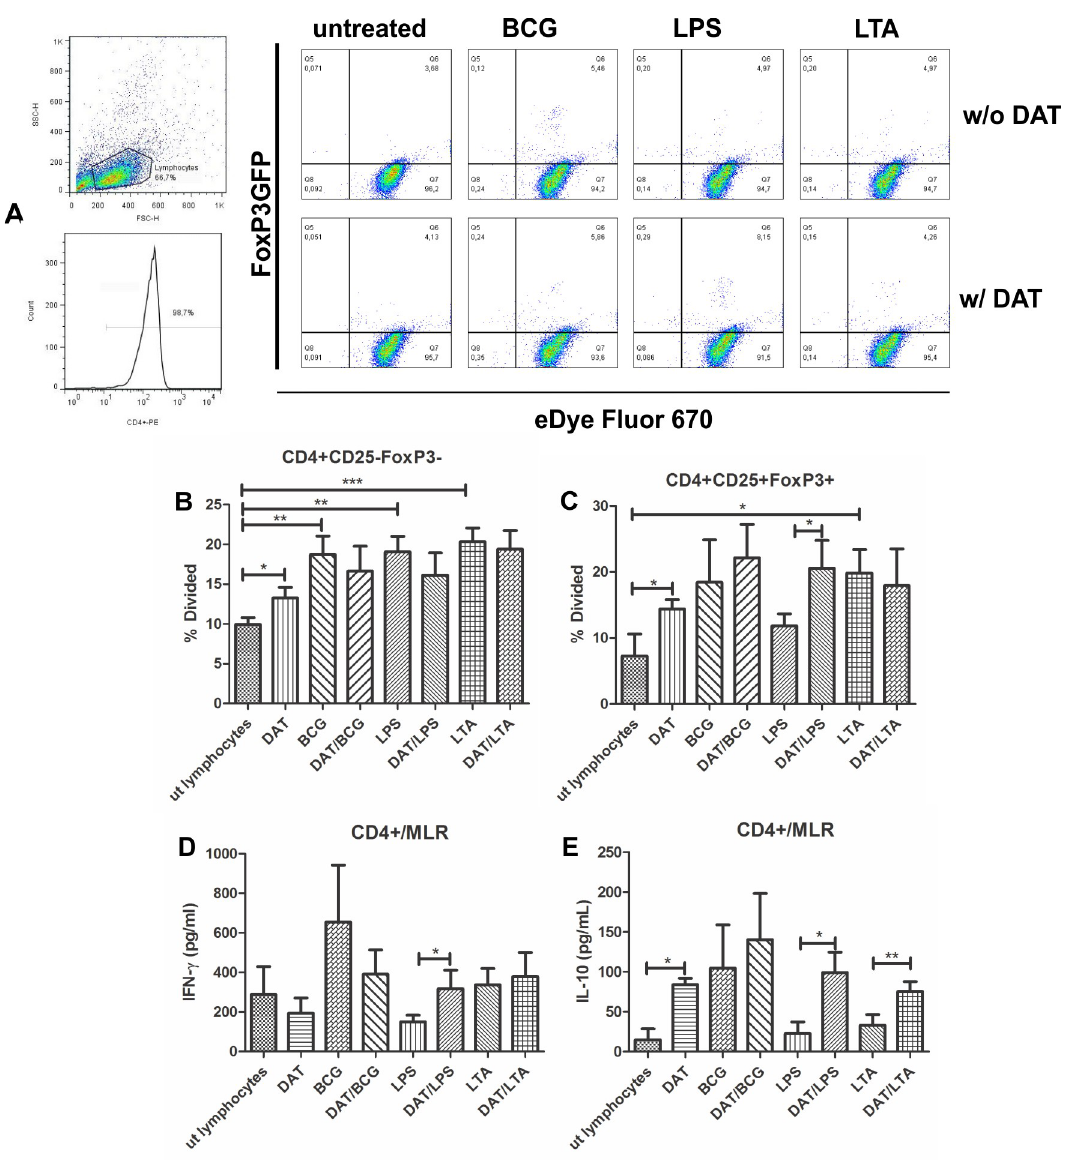
Fig 8. Di- O -acyl trehalose promotes the expansion of regulatory T lymphocytes. We studied the capacity of DCs activated with M . bovis /BCG antigens and TLR agonists with or without preincubation with DAT. DCs were cocultured with lymphocytes CD4 + CD25 - FoxP3 - and CD4 + CD25 + FoxP3 + lymphocytes obtained by cell sorting from Foxp3GFP + transgenic mice. The proliferation was measured by a dilution method with eDye Fluor 670 (A). Proliferation of FoxP3 - lymphocytes was observed in cocultures with DCs activated with DAT, BCG antigens, and LPS (p < 0.05; unpaired t Student’s test) (B). Proliferation of regulatory FoxP3 + lymphocytes was induced by CDs activated with LTA (p = 0.0169; unpaired t Student’s test); BCG and LPS activated DCs increase the proliferation of regulatory T lymphocytes, but results do not reach statistical significance. Of interest, DAT alone triggered the expansion of regulatory lymphocytes (p = 0.0463; unpaired t Student’s test), and when given together with LPS a positive synergistic effect was observed (p = 0.476; Mann Whitney test) (C). The production of cytokines in a mixed lymphocyte reaction with purified CD4 + was quantitated by ELISA in cocultures of DCs with splenic lymphocytes from Foxp3GFP + transgenic mice. Increased release of IFN- γ is observed with DCs activated with BCG antigens (D). The production of the anti-inflammatory cytokine IL-10 was upregulated in cocultures of lymphocytes with DCs treated with BCG, DAT/BCG, DAT/LPS and DAT/LTA but results were not statistically significant. When DCs were pretreated with DAT alone or DAT and LPS or LTA a synergistic effect in IL-10 production was observed (p < 0.05; Mann Whitney test) (E). The results of five independent experiments are shown.